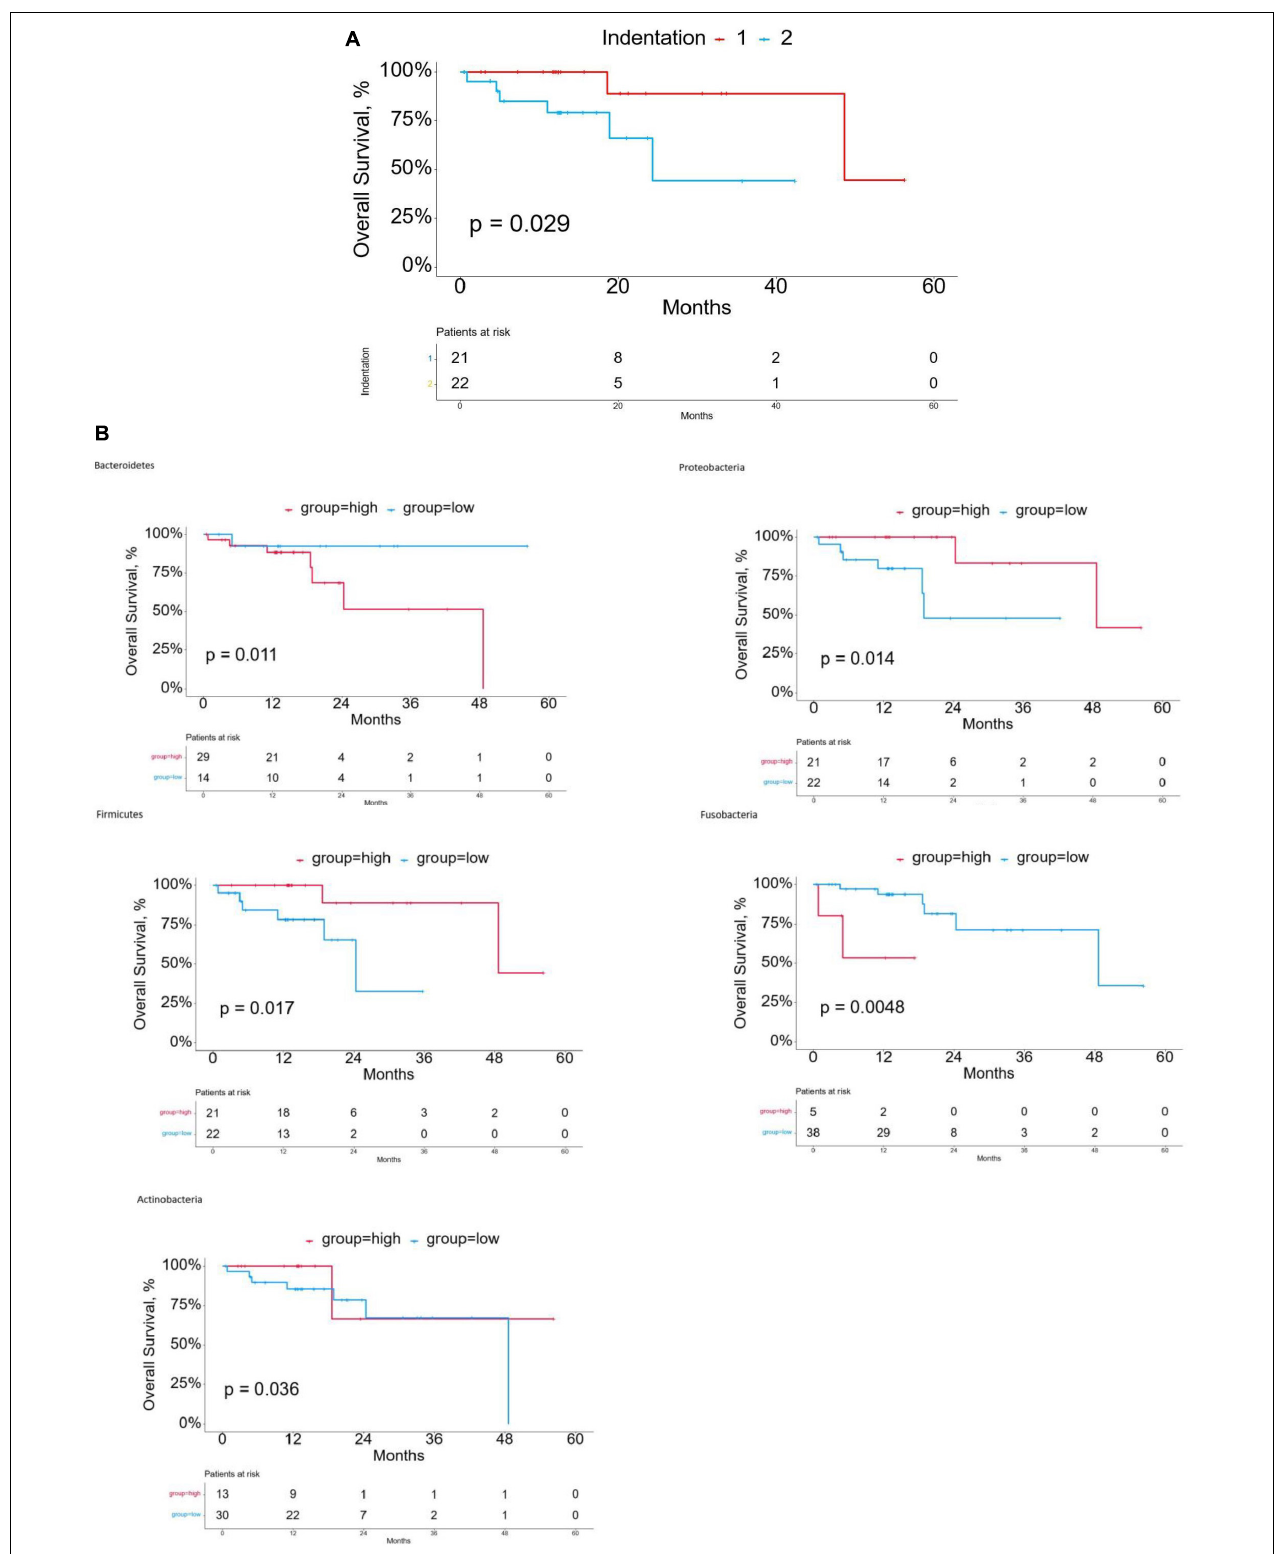
FIGURE 2 | (A) Kaplan-Meier curves for overall survival (OS) of cluster groups in the discovery cohort. (B) Kaplan-Meier curves for overall survival (OS) based on esophageal tissue-resident microbiota.